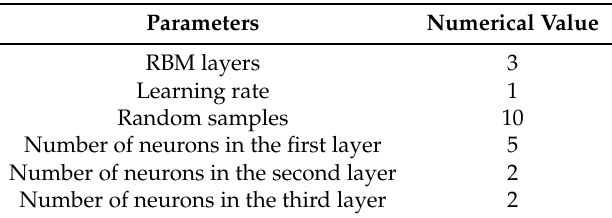
Table 1. DBN parameter